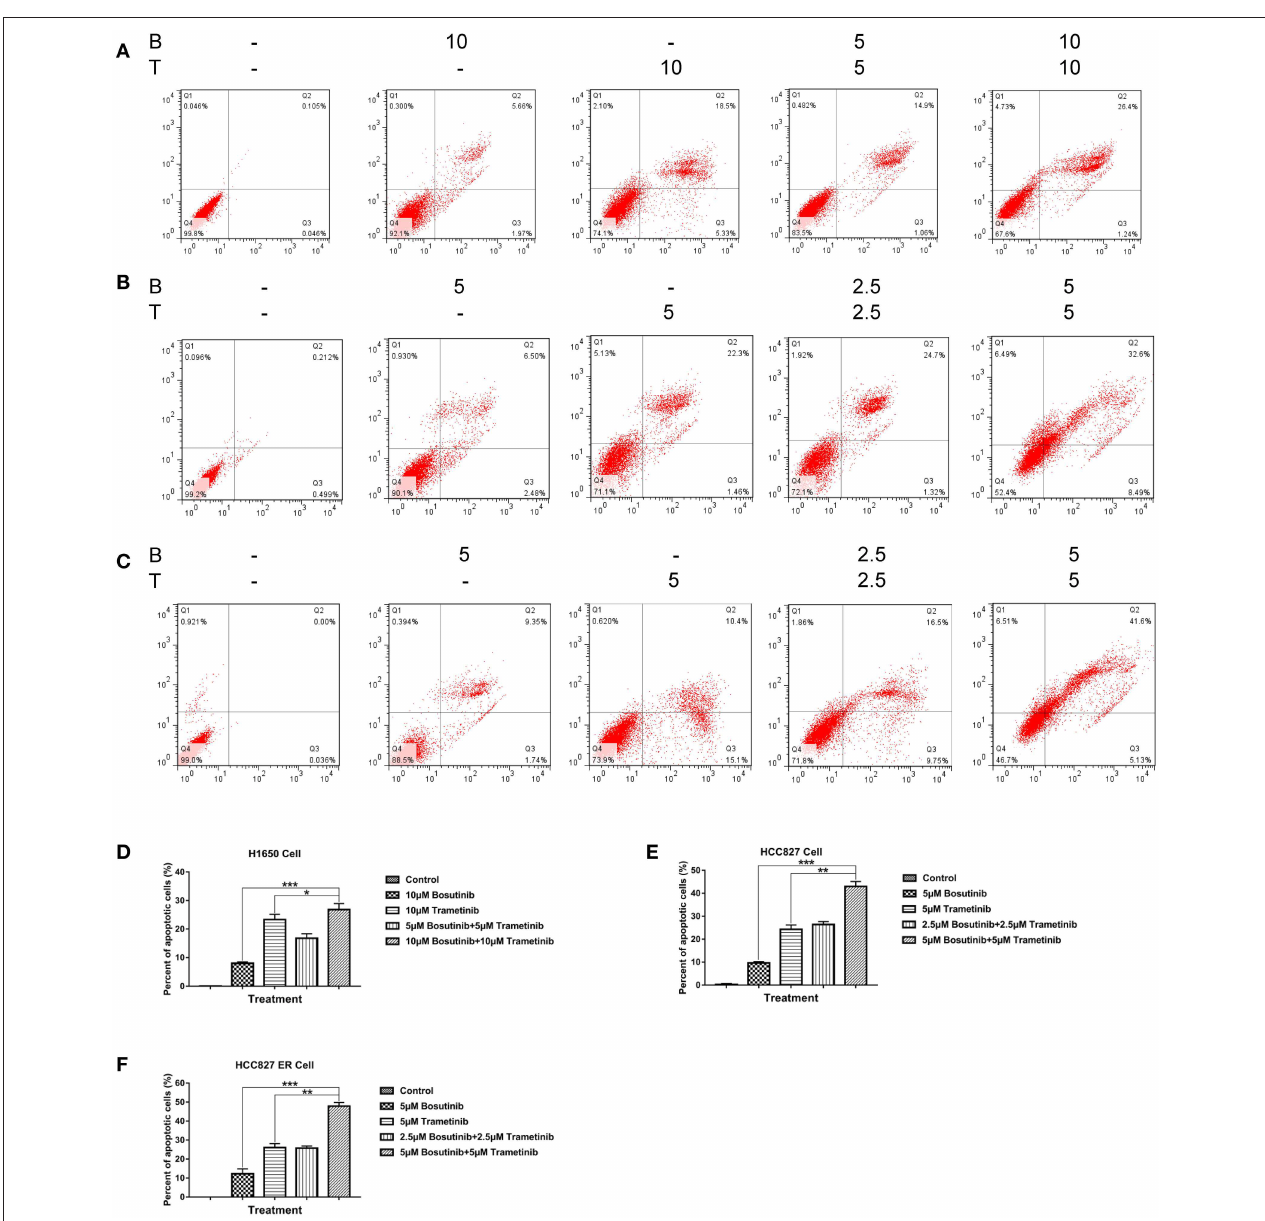
FIGURE 3 | Trametinib and bosutinib trigger apoptosis in NSCLC cell lines synergistically. Annexin V/PI flow cytometric analysis of drug-treated (A) H1650, (B) HCC827, and (C) HCC827 ER cells. Cells treated with trametinib, bosutinib, or their combination for 24h. The cells were then collected and were double-stained with an FITC-conjugated anti-Annexin V antibody and PI. The analyses were performed using a flow cytometer. Histograms of quantitative analysis of colony formation assay. (D) H1650, (E) HCC827, and (F) HCC827ER cell lines. The data are presented as mean ± S.D. * P < 0.05, ** P < 0.01, *** P <